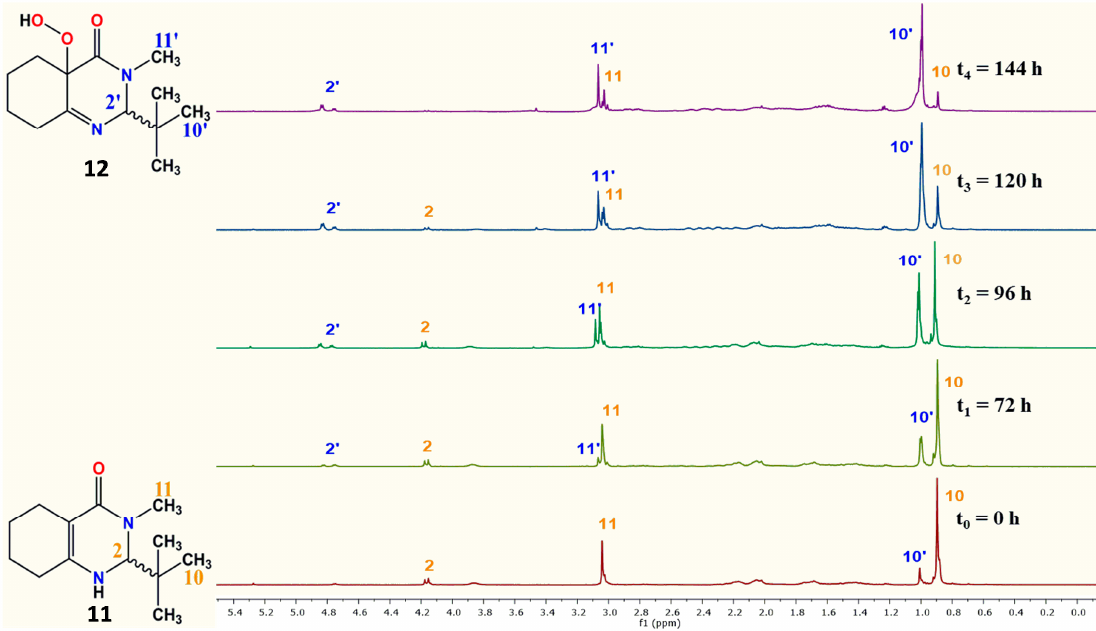
Figure 3. Kinetic study by 1 H-NMR of environmental exposure of 11 Figure 3 . Kinetic study by 1 H-NMR of environmental exposure of 11 .